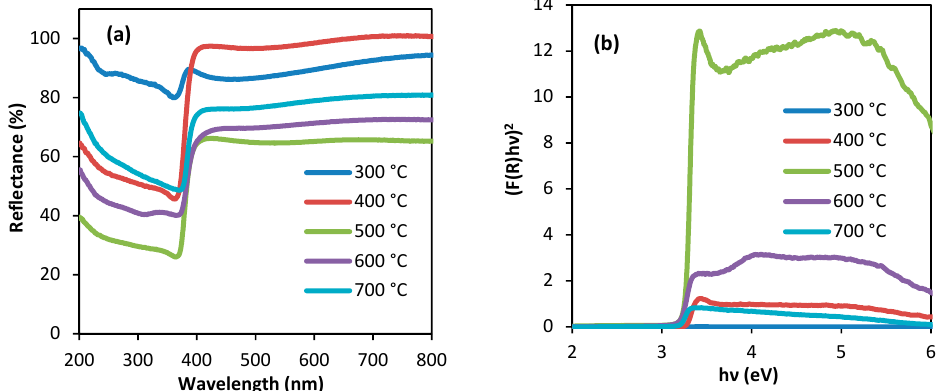
Figure 5. ( a ) Diffuse reflectance UV–visible spectra of Ag/ZnO and ( b ) Tauc plot of [F(R)h ν ] 2 versus photon energy at different calcination temperatures.